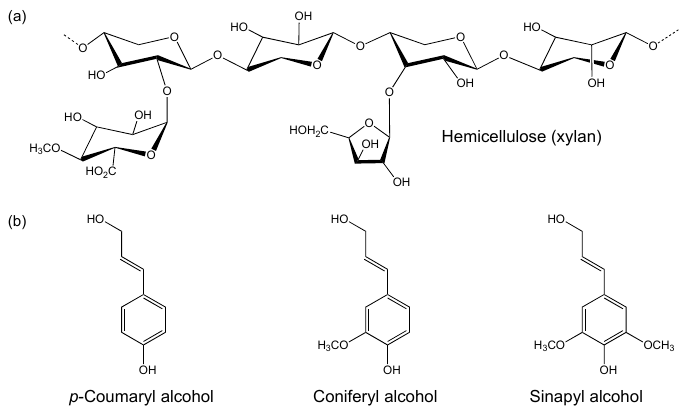
Figure 1. Enzymatic degradation of cellulose to glucose. Hemicellulose is a heterogenous polysaccharide that is comprised of a diverse array of C5 and C6 sugar monomers. It generally contains a xylan (major component), galacto(gluco)mannan or xyloglucan backbone [45] with branching side chains (Figure 2a) [46]. Differences in hemicellulose composition are seen between plant species, including the range of sugar and sugar acid classes present and their linkage types. These mono- meric units include D -xylose, D -mannose, D -galactose, D -glucose, L -arabinose, 4-O-methyl glucuronic acid, D -galacturonic and D -glucuronic acids [42]. The monomers are linked via β -1,4- and β -1,3-glycosidic bonds. Given the diversity in hemicellulose composition, effi- cient degradation requires a broad range of hemicellulases compared to cellulose break- down [47]. Hemicellulose is considered to be of lower value as a carbon source compared to cellulose due to the presence of C5 sugars, which are often not degraded by microor- ganisms [48].